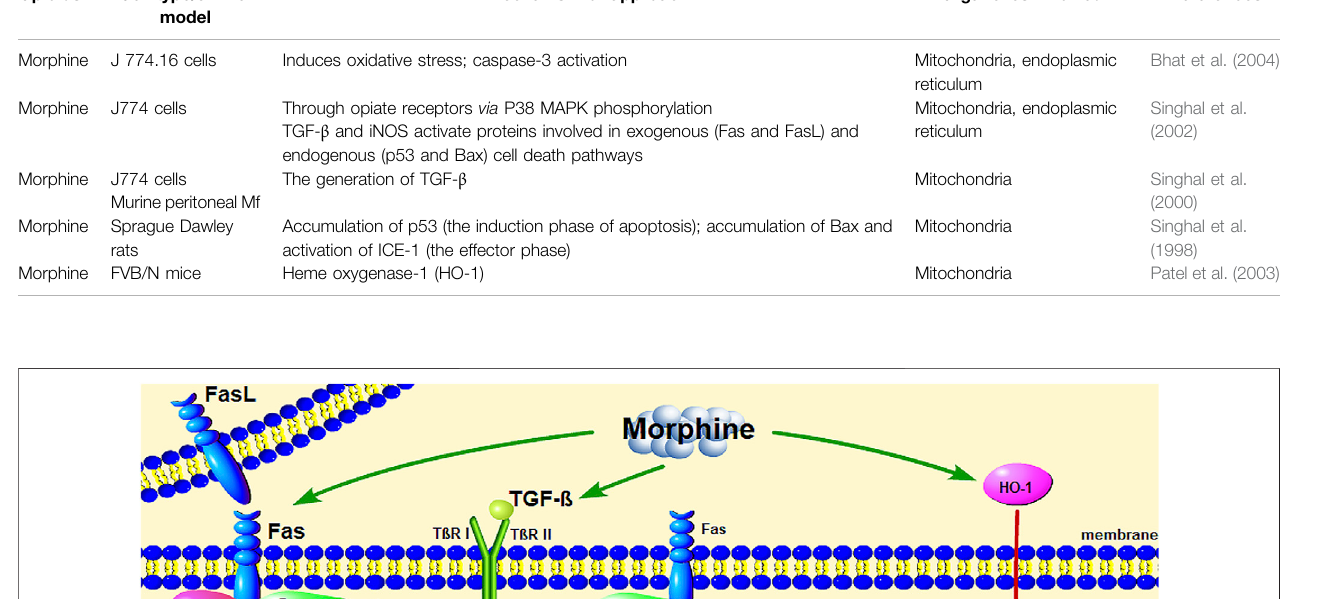
TABLE 3 | Opioids affect the apoptosis of macrophages.